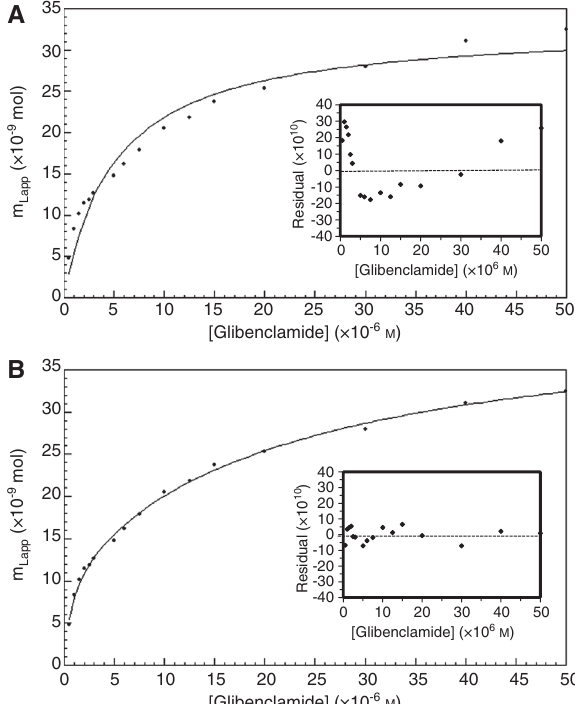
Figure 8 Analysis of data obtained for the frontal analysis of glib- enclamide on an HPAC column containing normal HSA when plotted according to (A) a single-site binding model based on Equation (1) or (B) a two-site binding model based on Equation (3). The insets show the corresponding residual plots, where each point represents the average of four experiments (Matsuda et al.